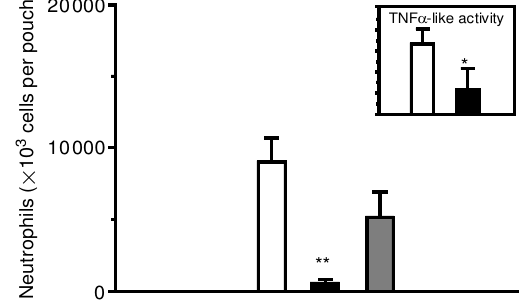
Table 2. Failure of mepyramine on LPS-induced recruitment of leukocytes and neutrophils into rat air pouches. The effects of mepyramine (1 and 4 mg / kg, i.p., 0.5 h before LPS) on neutrophil recruitment were evaluated for the dose of 200 ng of LPS (2 h, into the pouches). Results are FIG. 4. Interference of cycloheximide (6 ng) injected into the expressed as mean SEM of total number of cells per rat air pouch 2 h before LPS with both neutrophil recruit- pouch for n = 5 experiments. No result was statistically ment and TNF- a like activity. Cycloheximide was injected different from the control group under a volume of 1 ml with PBS, either 2 h before or together with LPS (200 ng). Responses are for neutrophils Mepyramine and TNF- a like activity (box). Results are expressed as mean (4 mg / kg) SEM of total number of cells per pouch ( n = 5) for the recruitment and of TNF- a like activity concentrations recov- ered in the air pouch washing supernatants for n = 5. Cycloheximide-treated animals, 2 h befere LPS ( j ), together with LPS ( ) and vehicle-treated animals ( h ) ( P , 0.05, P , 0.01). Mediators of In¯ ammation ´ Vol 6 ´ 1997